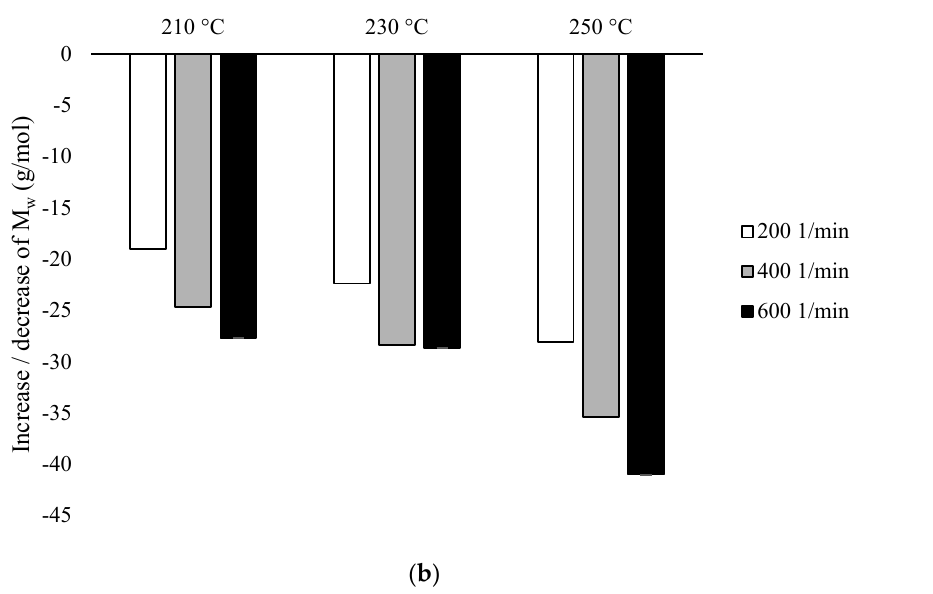
Figure 3. Weight average molecular weight (M w ), differences % with non-extruded PLA: ( a ) configuration 1; ( b ) configuration of 2. Abbreviations: as in Table 1.